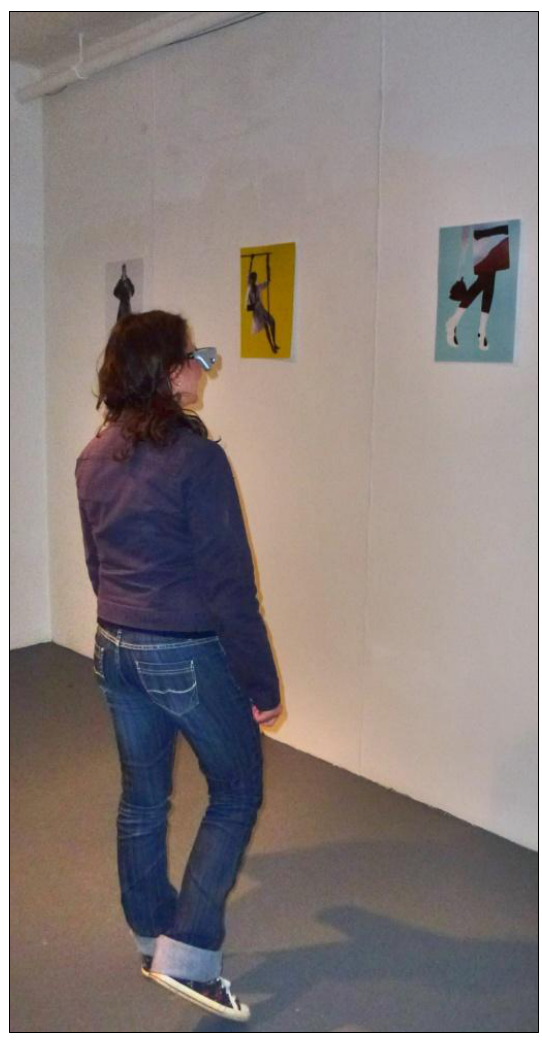
Figure 5. A simulation of the experimental procedure. Participants were wearing a mobile eye-tracking device, recordings of which are reported elsewhere